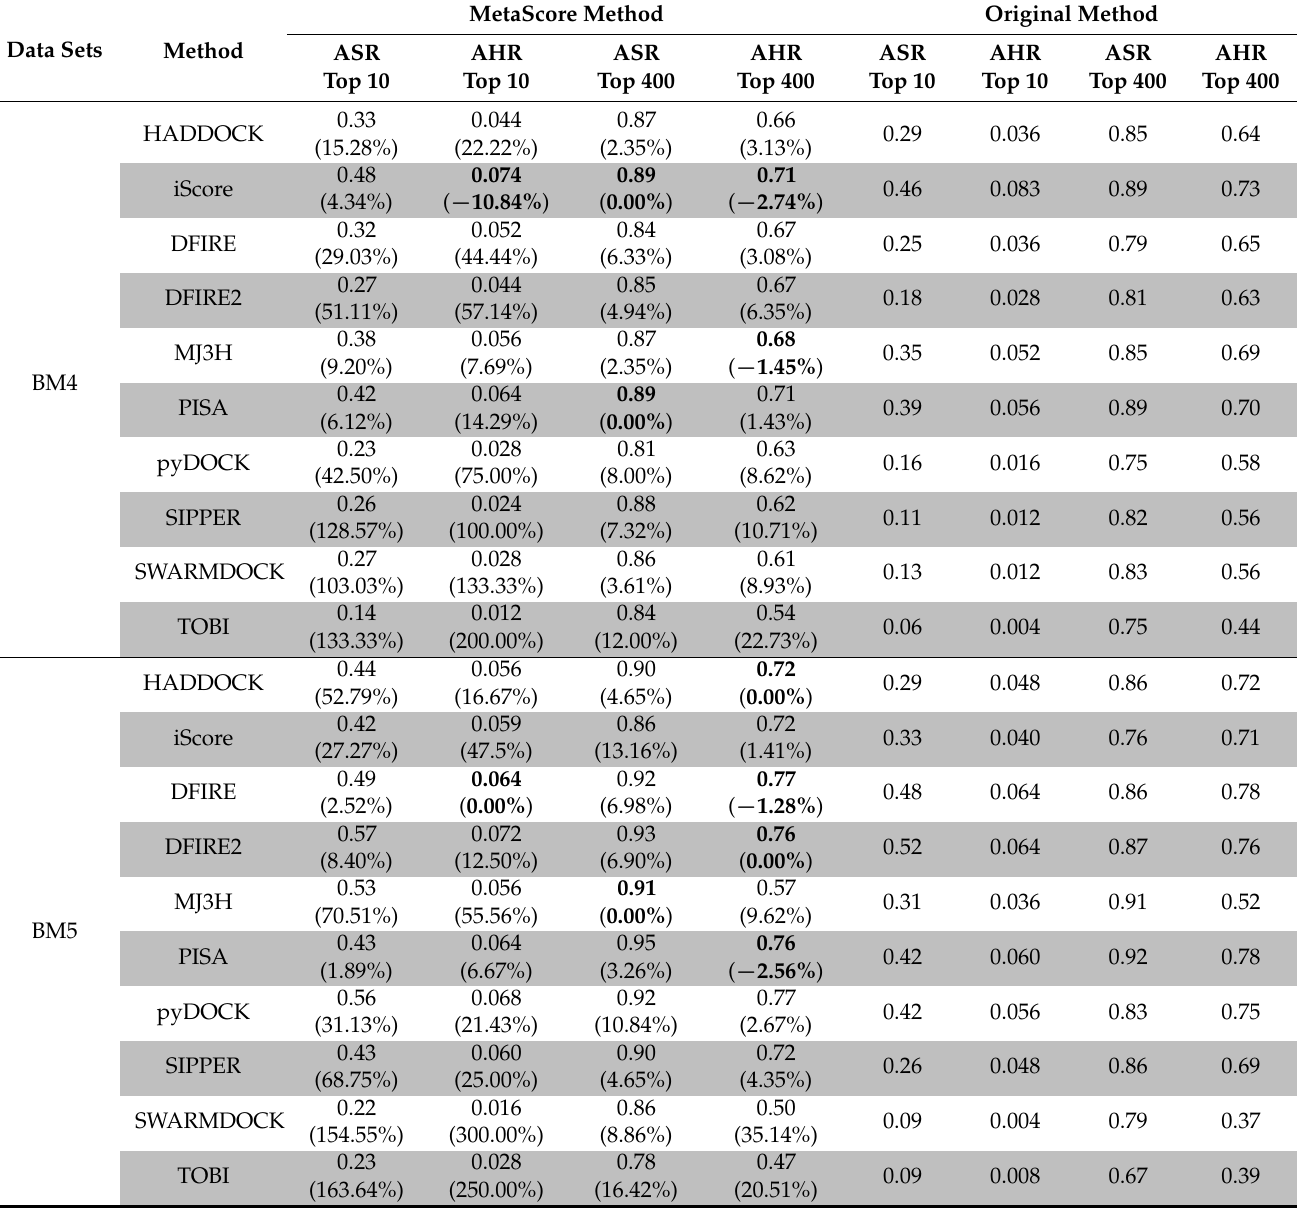
Table 3. Performance comparison of before and after combining classical scoring methods with each of their corresponding RF classifiers using the BM4 decoy training set and BM5 decoy set, which is a set of decoys generated by HADDOCK from the newly added docking cases to the protein–protein docking benchmark Version 5.0. Our MetaScore approach improved the performance of all scoring functions we evaluated. Numbers in parentheses indicate percentages of increase from original methods. Values with no increase are highlighted in